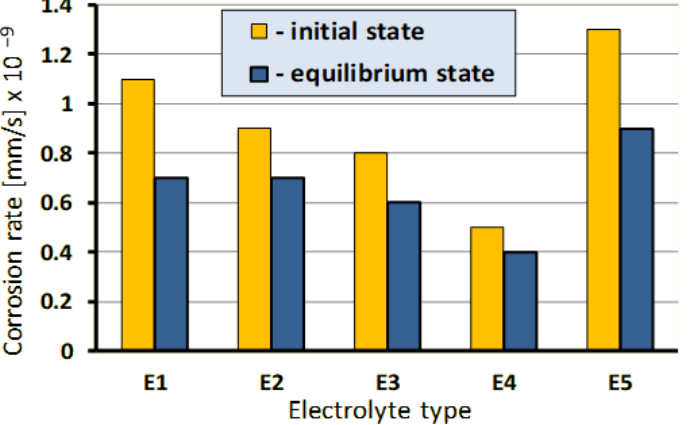
Figure 9. The effect of the electrolyte composition on the corrosion rate of constructional steel; Electrolytes as in Table